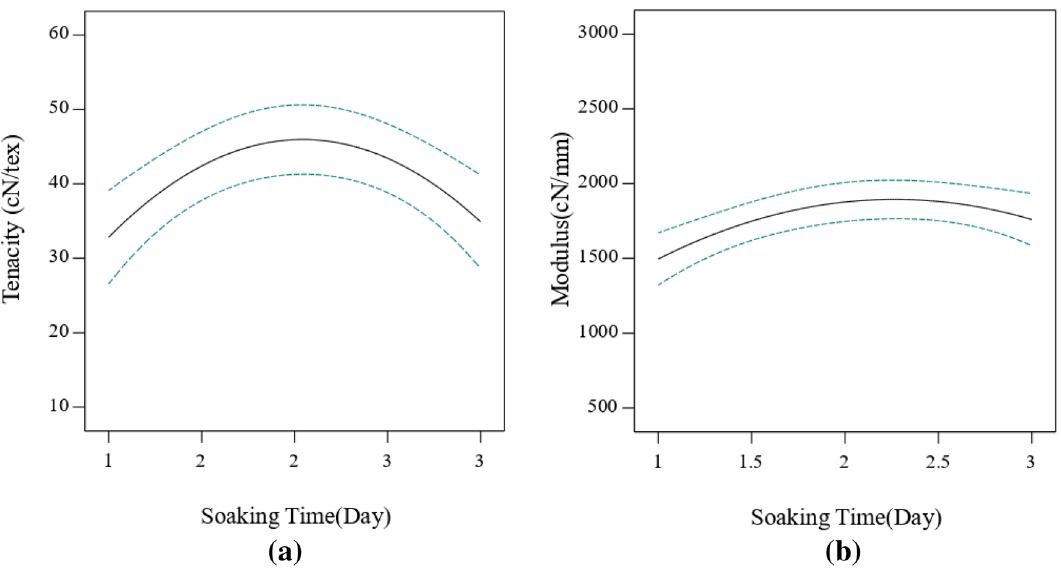
Fig. 10 independent variables effect on the responses a Soaking time versus Tenacity b Soaking time versus